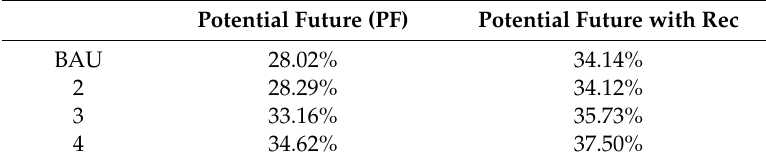
Table 9. The proportion of the CSA that is forested by the end of the planning horizon in NM without and with applying the subsidised mandatory public access for all forests (Rec) backcasting policy to the four potential